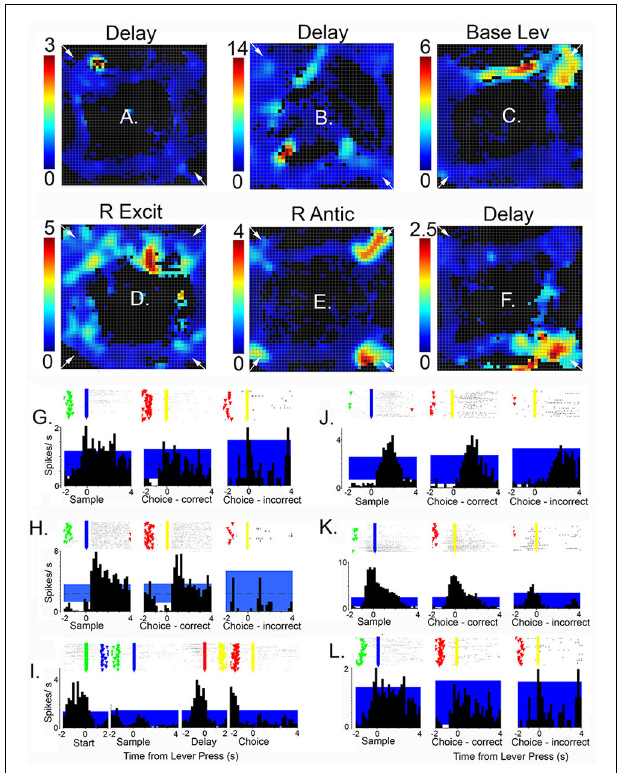
FIGURE 9 | Heat maps, raster plots, and peri event time histograms (PETHs) of neurons exhibiting spatially-restricted event-related responses. Results are shown for six neurons, three with delay-related responses (A,G,B,H,F,L) , along with examples of base lever press (C,I) , reinforcement excitation (D,J) , and reinforcement anticipation (E,K) . Heat maps are oriented with levers/drinking spouts in each corner. Calibration bars to the left indicate activity in spikes/s. Rasters show activity in trial 1 at the bottom and trial 60 at the top with event markers for lever presses (green, blue, red, and yellow for the start, sample, delay, and choice lever presses, respectively). Time scales and aligned events are matched for PETHs and overlying raster plots. The blue band marks the 99% confidence interval for PETHs. This figure is reproduced from Onos et al. (2016).